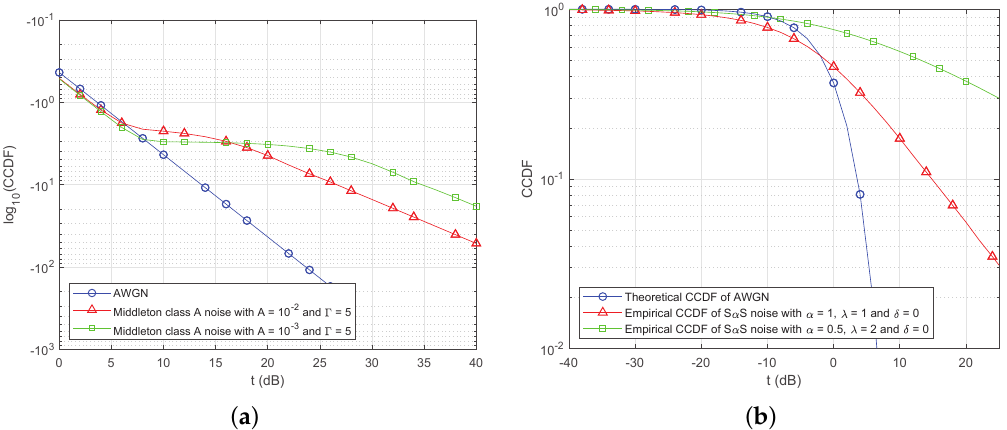
Figure 4. Illustration of theoretical CCDF of AWGN and empirical CCDFs of impulsive noise models. ( CCDF ) s of AWGN and Middleton class A noise with ( A , Γ ) = ( 0.1,1 × 10 − 3 ) and ( a ) Theoretical log 10 ( 0.35,1 × 10 − 2 ) on a log scale. ( b ) Theoretical CCDF of AWGN and empirical CCDFs of S α S noise with ( α , λ , δ ) = (1,1,0) and (0.5,2,0) on a log scale.